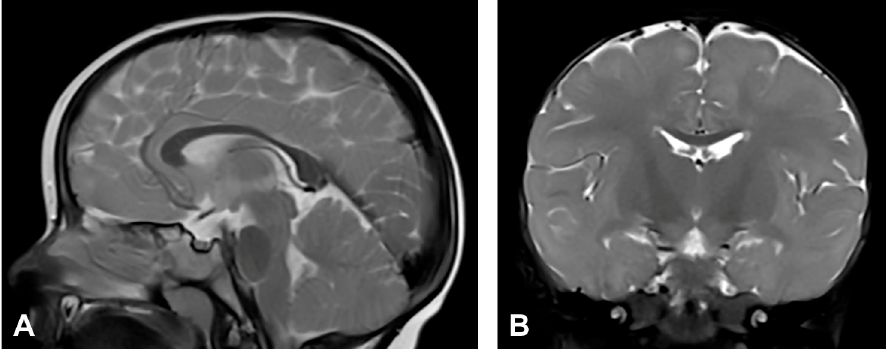
Figure 5. (Case 5) ( A ) Sagittal and ( B ) coronal T2W magnetic resonance images at the age of two without pathological findings.